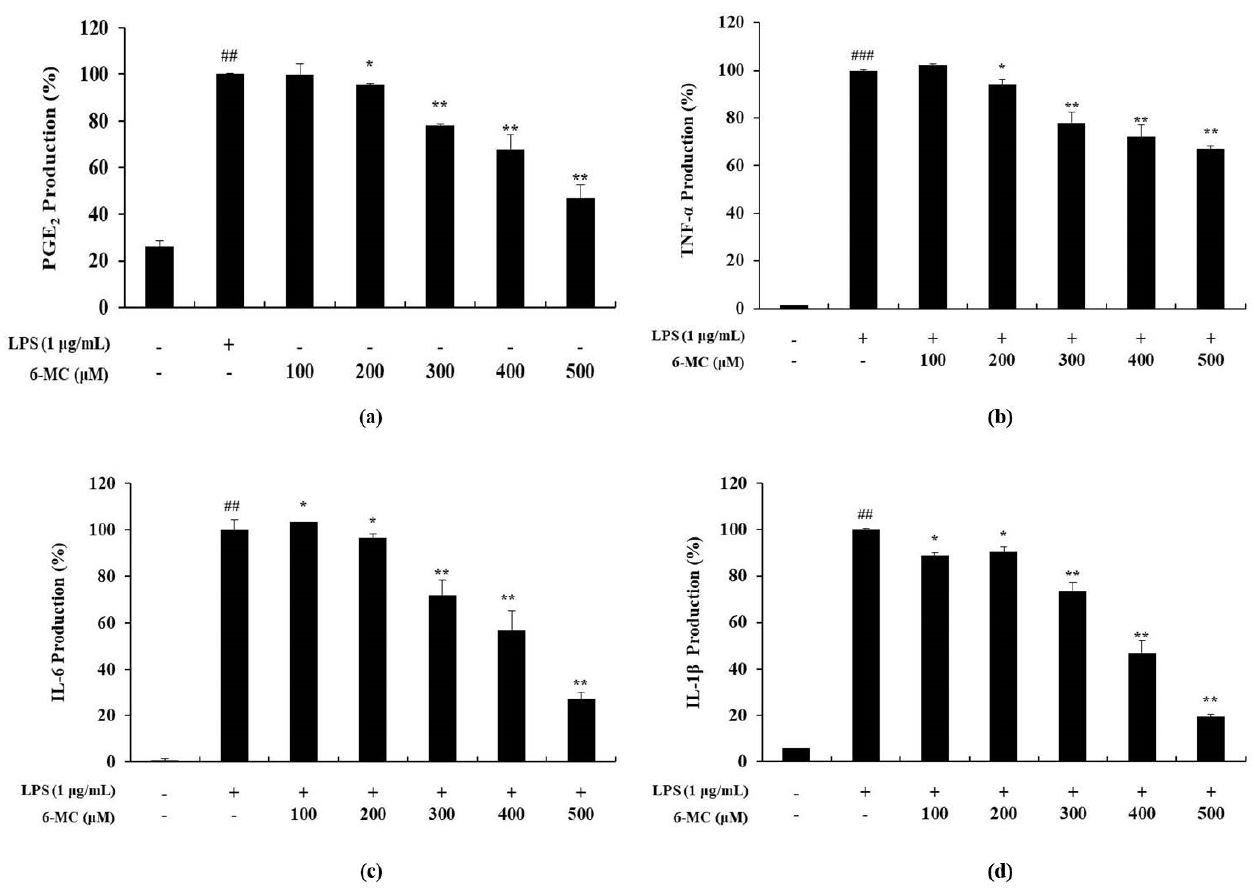
Figure 4. Effect of 6-MC on the production of PGE 2 and pro-inflammatory cytokines in LPS-induced RAW 264.7 cells. Cells were pretreated with 6-MC for 1 h and subsequently stimulated for 24 h with LPS. ( a ) PGE 2 , ( b ) TNF-α, ( c ) IL-6, and ( d ) IL-1β production was determined by ELISA. The results are presented as the mean ± SD from three independent experiments. ## p < 0.01 vs. untreated control group. * p < 0.05, ** p < 0.01 vs. group treated with LPS alone.